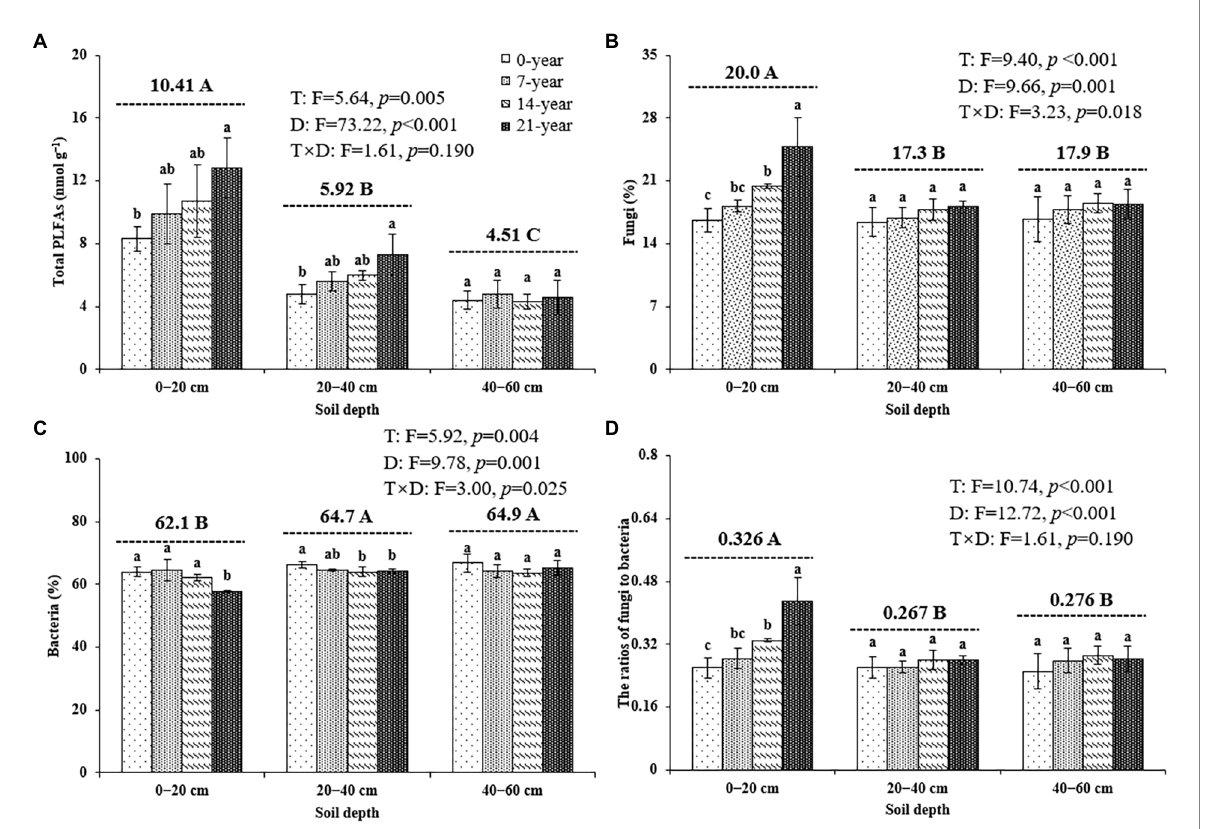
FIGURE 2 The contents of total PLFAs (A) , the proportions of fungi (B) , and bacteria (C) as well as the ratios of fungi to bacteria (D) at three soil depths (0–20, 20–40, and 40–60 cm) under different ages of walnut plantations. Uppercase and lowercase letters represent significant differences ( p < 0.05) among different soil depths and different ages of walnut plantations in the same depths, respectively. Two-way ANOVA was applied for identifying the effects of walnut plantation ages, soil depths, and their interaction on the above indices (The data is shown in the upper right corner). T, walnut plantation ages; D, soil